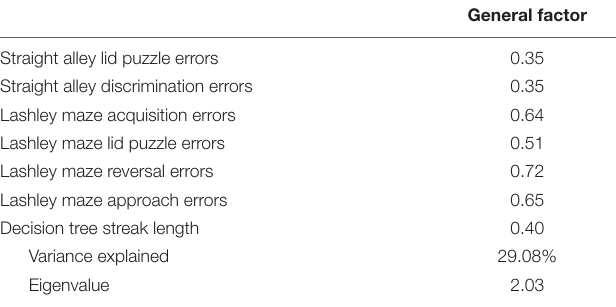
TABLE 3 | Principal component analysis of seven cognitive tests ( n =